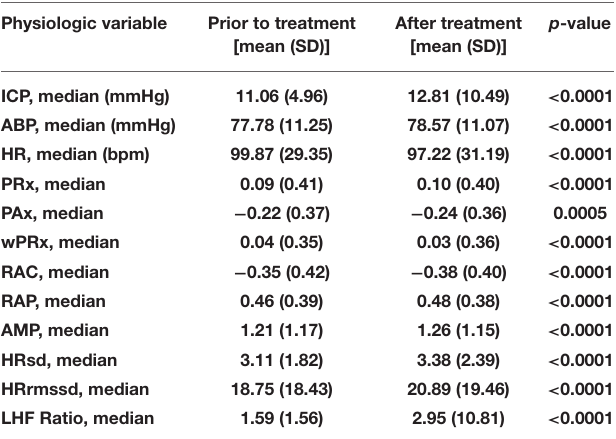
TABLE 4 | Differences in cerebral physiology in relation to hyperosmolar therapy without intracranial hypertension. Physiologic